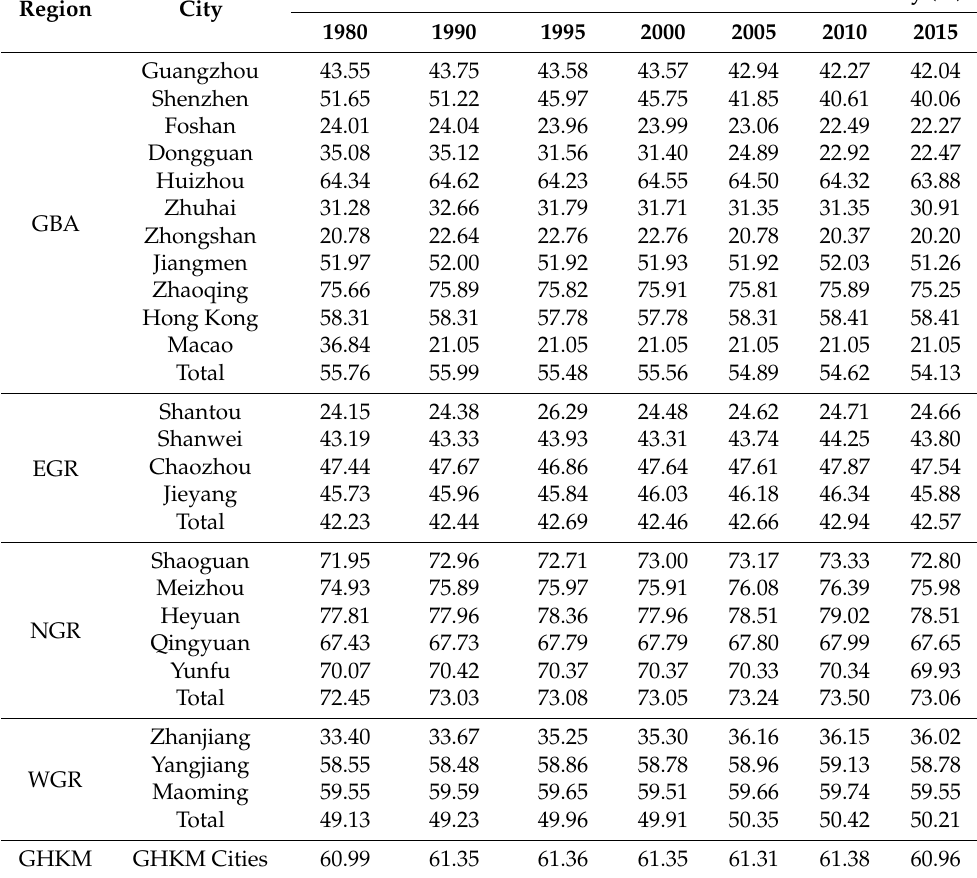
Table 2. Forests’ spatial dynamics in GHKM from 1980 to